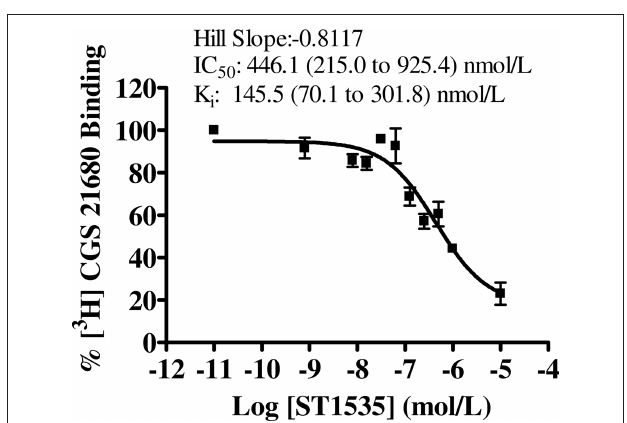
FiGure 4 | Dose–response curves of compound-mediated displacement of [ 3 H]CGS21680 binding to rat hippocampus. The ordinates represent the specific binding of 30 nmol/L [ 3 H]CGS21680 in the presence of different